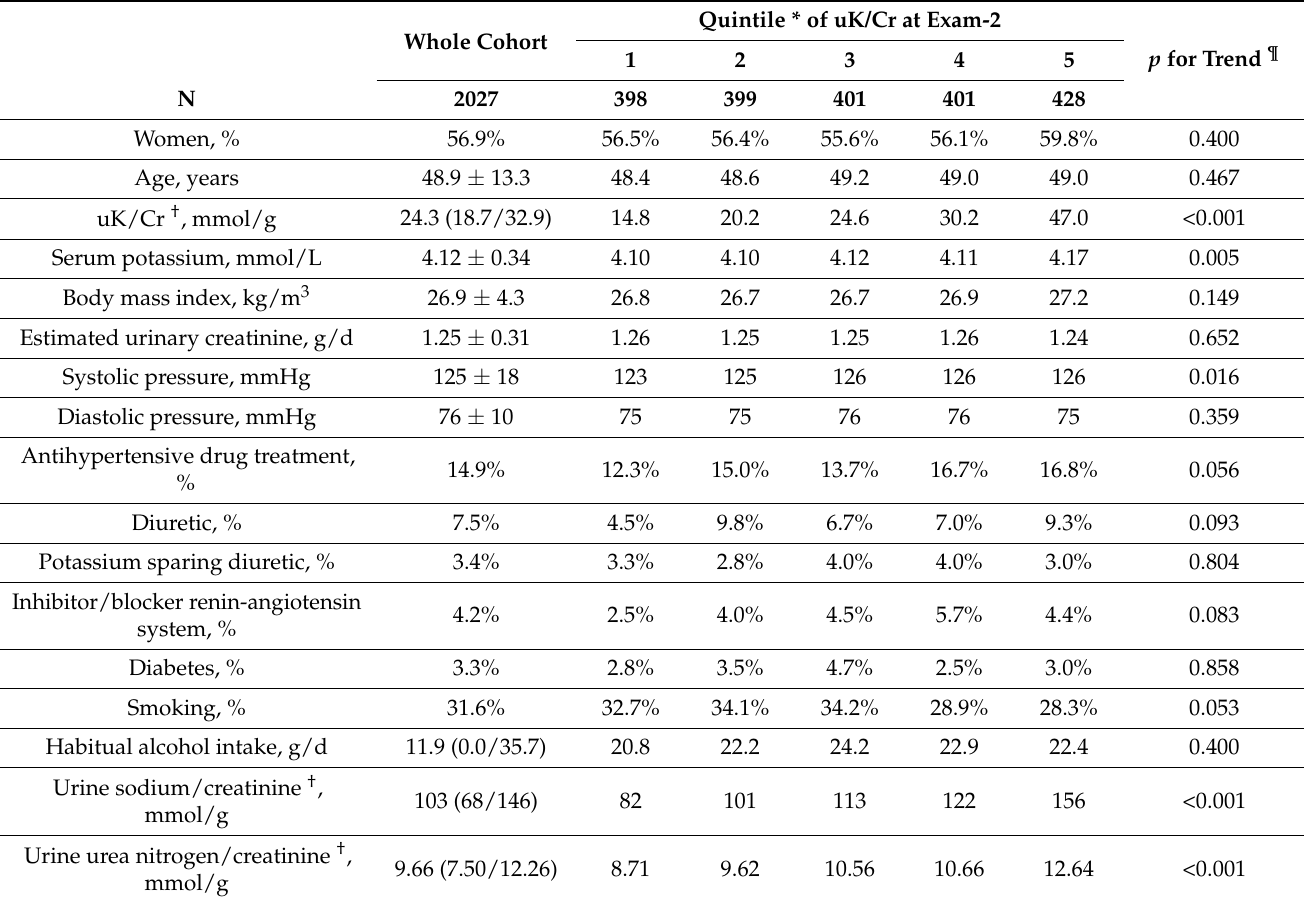
Table 2. Descriptive statistics for data of exam-2 in whole cohort (prevalence for categorical variables, mean ± SD for non-skewed numerical variables, and median with interquartile range for skewed variables) and trend analyses by quintiles of uK/Cr (prevalence or